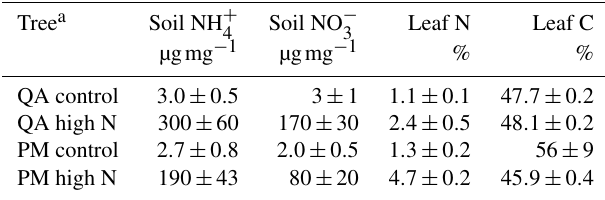
Table 1. Average soil and leaf nitrogen. Tree